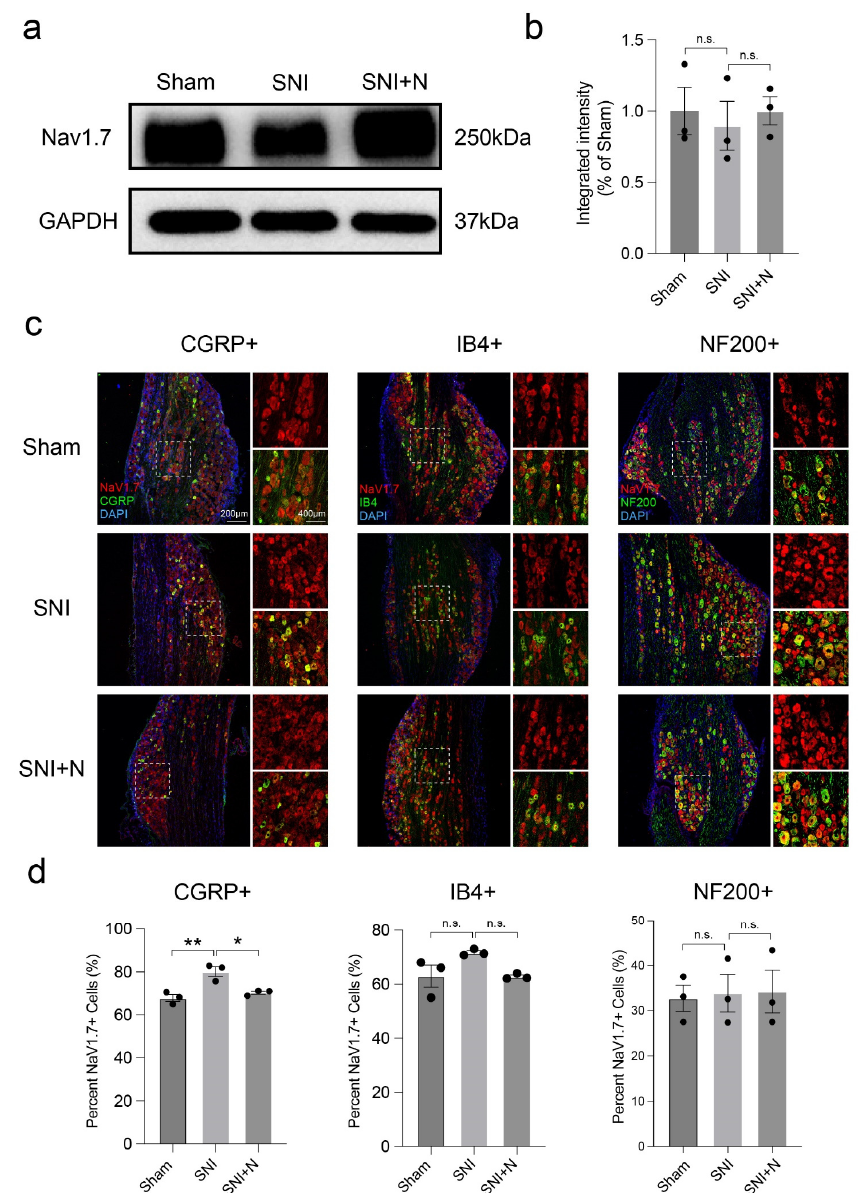
Figure 8. Expression of Na v 1.7 in different types of DRG sensory neurons. ( a , b ) Western blot analysis expression level of Na v 1.7 isolated from lysates of L4-L6 DRGs from the ipsilateral side of the lumbar spine among Sham, SNI, and SNI treated with Narirutin (SNI + N). ( c ) Representative immunofluorescence images of Na v 1.7 in DRG neurons of the ipsilateral side of L4-L6 DRGs slices from Sham, SNI, and SNI + N with corresponding co-localization (white arrow). Nuclei were stained with DAPI (blue). Left: peptidergic neurons were labeled using calcitonin gene-related peptide (CGRP, green), which was co-labeled with Na v 1.7 (red). Merged images show CGRP-containing peptidergic neurons co-labeled with Na v 1.7 (yellow). Middle: non-peptidergic sensory neurons are labeled using Isolectin B4 (IB4, green), which is co-labeled with Na v 1.7 (red) and is shown in the merged image (yellow). Right: myelinated neurons were labeled using NF200 (green), which was co-localized with Na v 1.7 (red), and the merged image shows its co-localization (yellow). ( d ) Co-localization analysis of CGRP, IB4, NF200 with Na v 1.7 in DRG neurons. Data are expressed as means ± SEM. Asterisks indicate statistical significance compared with vehicle treatment (* p < 0.05, ** p < 0.01, one-way ANOVA followed by Tukey’s test, n = 3 rats per